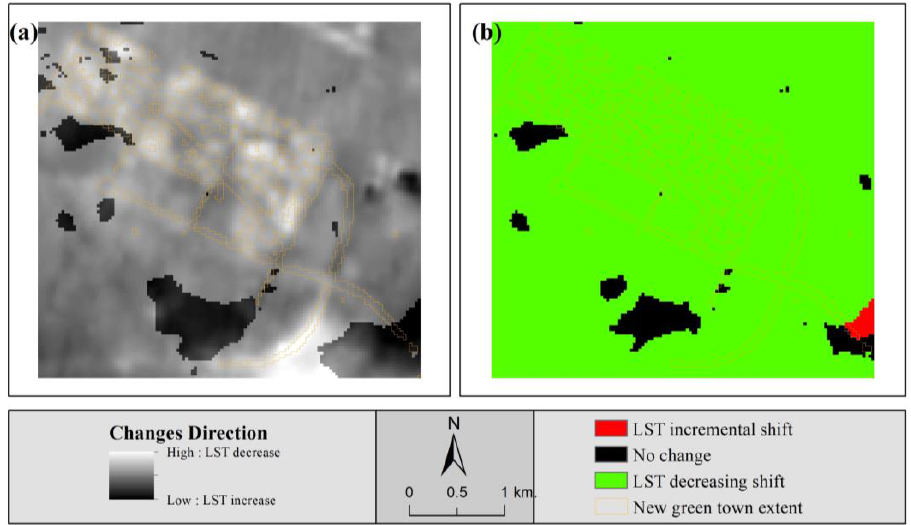
Figure 11. The difference in land surface temperature (LST) values between 2022 and 2013 in two representations of continuous values ( a ) and discrete classes ( b )